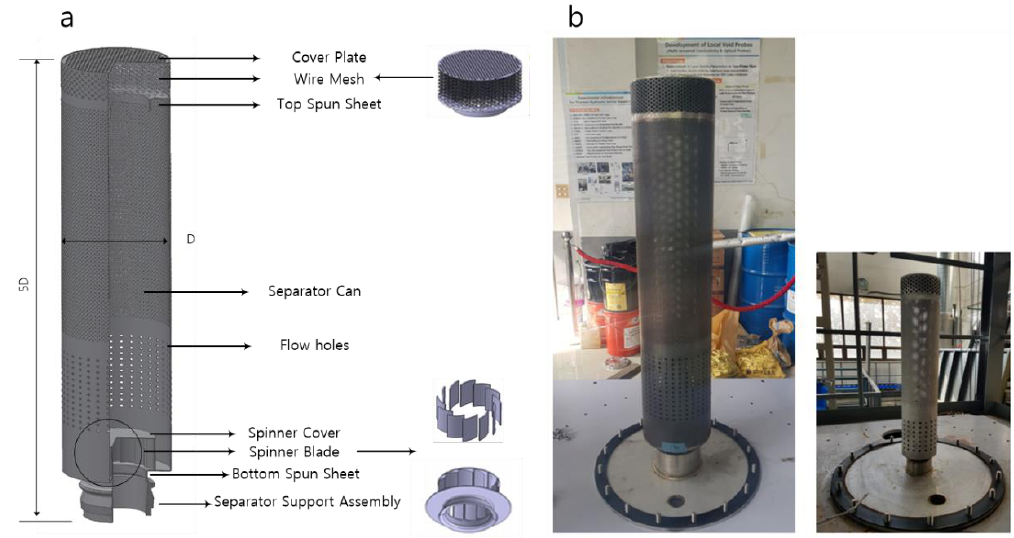
Figure 3. Moisture separator of OPR1000 reactor: ( a ) conceptual configuration; ( b ) photograph of test section.